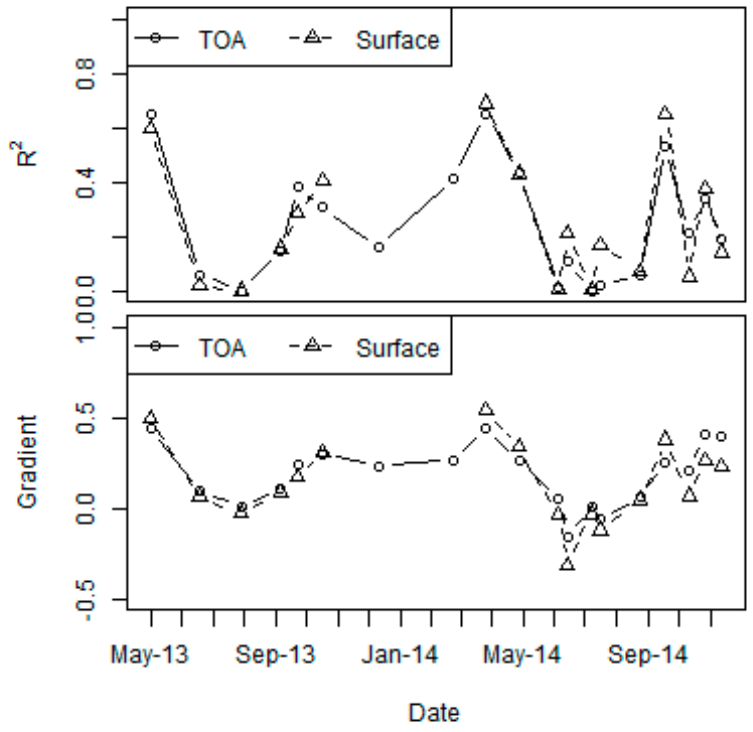
Figure 4. Time series of gradient and R 2 values for the relationship between ANPP (g dry mass m − 2 year − 1 ) and NDVI (all habitats) for NDVI imagery produced using both top-of-atmosphere reflectance and surface reflectance. Table 3. Coefficient of determination, R 2 , and standard errors, SE, for the relationship between single-date NDVI and ANPP (all habitats). Only results where R 2 > 0.5 are shown. Results are shown for NDVI imagery produced using both top-of-atmosphere reflectance and surface reflectance products. TOA